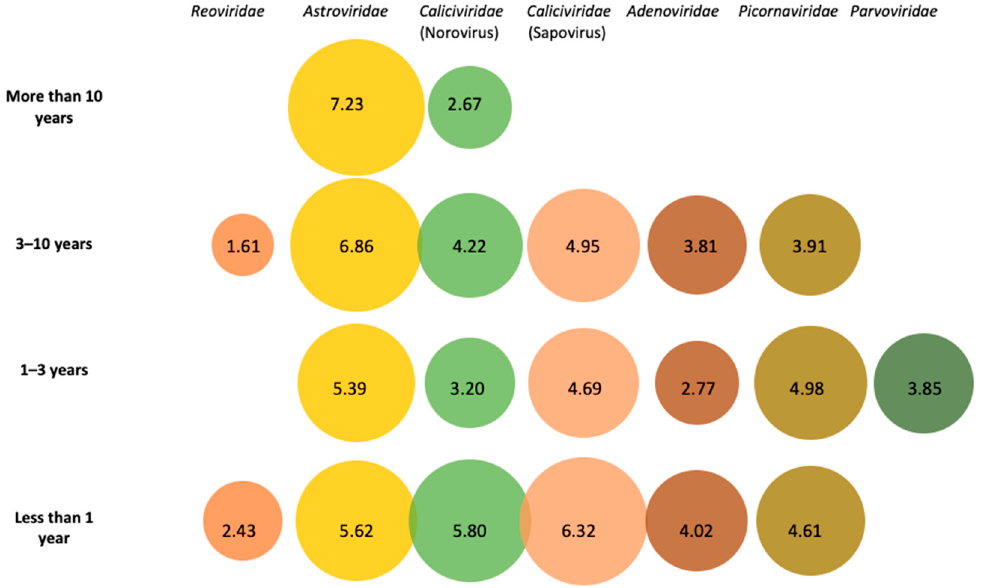
Figure 1. Age distribution of the number of reads (log10) from human viral families with etiologically related members with viral gastroenteritis.